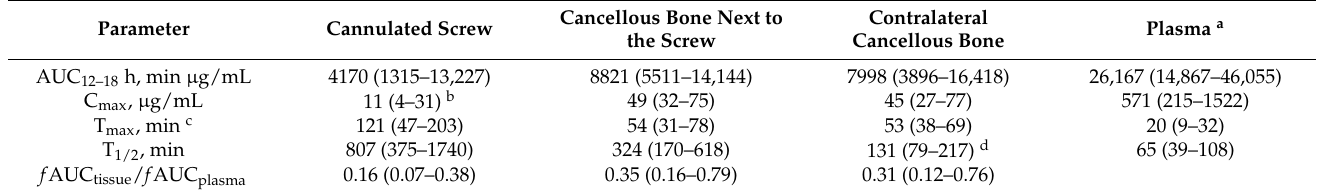
Table 2. Piperacillin pharmacokinetic parameters presented as medians (95% confidence intervals) in the third dosing interval (steady-state concentration).